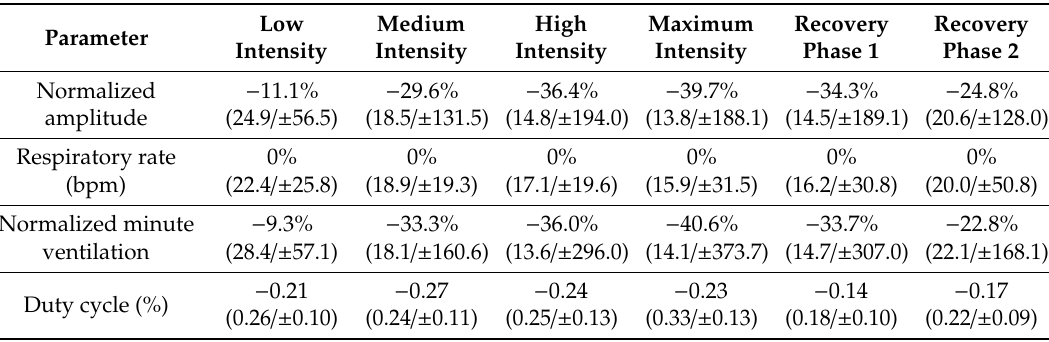
Table 3. Exercise test and recovery, all intensities, all parameters. Aggregated data are expressed as relative error median percentage, interquartile range (IQR) and limits of agreement (LOAs), computed as ± 1.96SD. IQR and LOAs are presented in brackets (IQR /